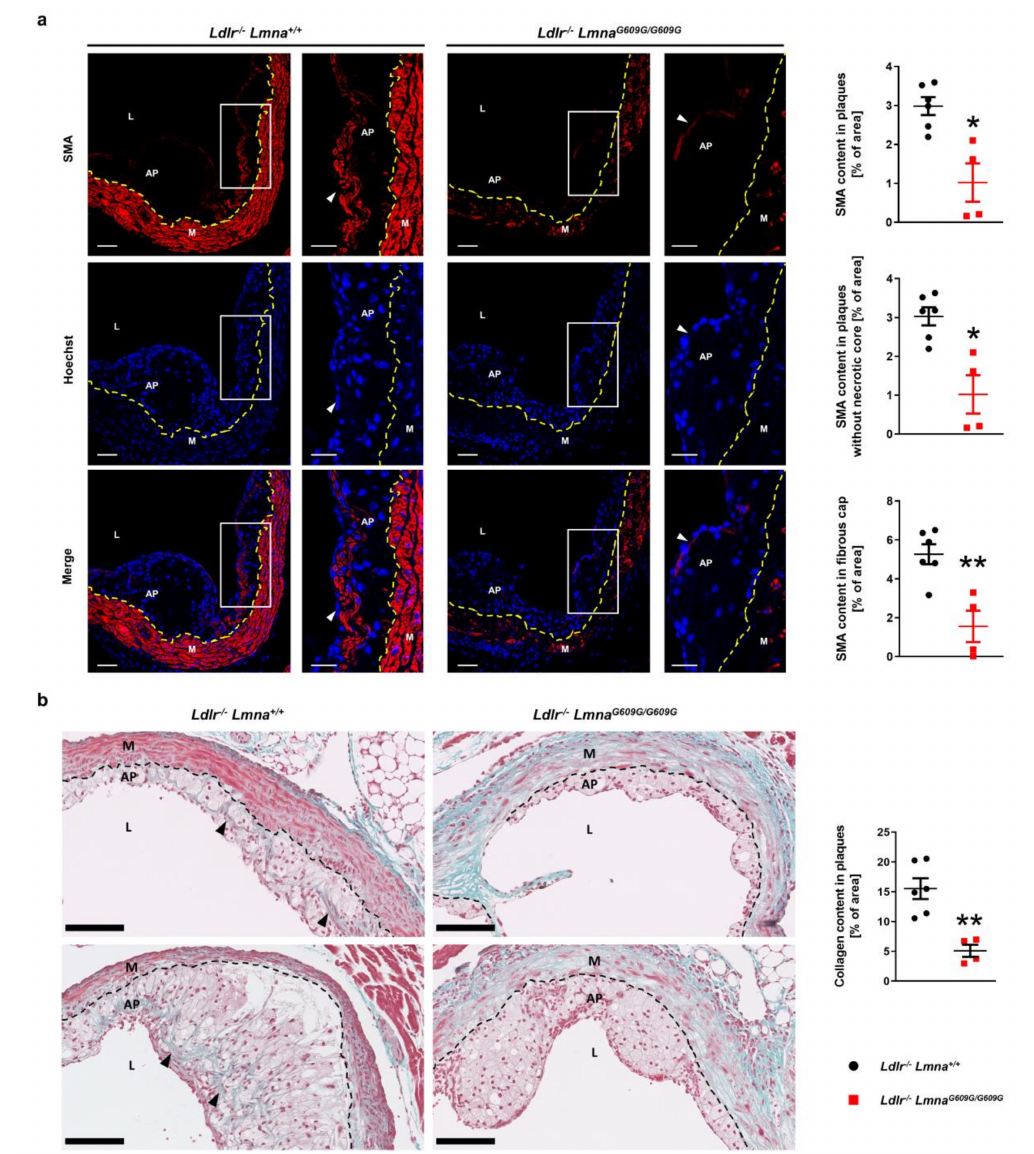
Figure A3. Lower smooth muscle cell and collagen content in atheromas of fat-fed female Ldlr − / − Lmna G609G / G609G mice. Female mice were fed a high-fat diet from eight weeks of age and were sacrificed at 16 weeks of age. ( a ) Representative fluorescence images of aortic root sections stained with an anti- α -smooth muscle actin (SMA) antibody (red) and Hoechst 33342 nuclear dye (blue). Discontinuous yellow lines indicate the separation between the media and atheroma plaques. White arrowheads indicate smooth muscle cells in the fibrous cap. Scale bar, 50 µ m. Graphs show smooth muscle content in atherosclerotic plaques (% of area positive for SMA) (top graph), in the cellular parts of plaques (without necrotic cores; middle graph), and in the fibrous cap (6 µ m band below the endothelium; bottom graph) of Ldlr − / − Lmna +/+ mice ( n = 6) and Ldlr − / − Lmna G609G / G609G mice ( n = 4). ( b ) Representative images of aortic root sections stained with Masson trichrome. Discontinuous black lines indicate the separation between the media and atheroma plaques. Black arrowheads indicate collagen. Scale bar, 100 µ m. The graph shows collagen content (% of blue area) in atheroma plaques of Ldlr − / − Lmna +/+ mice ( n = 6) and Ldlr − / − Lmna G609G / G609G mice ( n = 4) mice. Data are presented as mean ± SEM. Each point represents the mean for three aortic root sections per mouse. Statistical analysis was performed by two-tailed t -test with Welch´s correction in ( a ) and by two-tailed t -test in ( b ). *, p < 0.05; **, p < 0.01. AP, atheroma plaque; M, media; L,